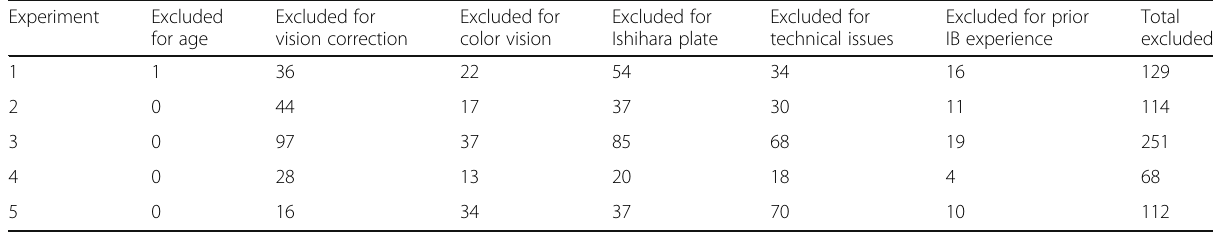
Table 2 A breakdown of the number of subjects excluded by each criterion in each experiment Experiment Excluded Excluded for Excluded for Excluded for for age vision correction color vision Ishihara